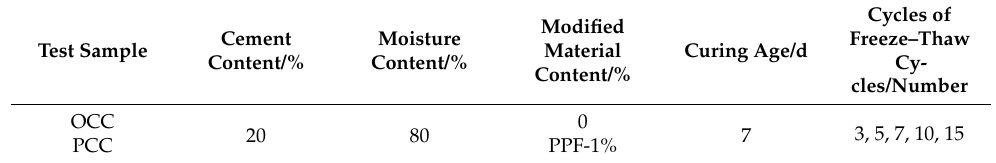
Table 4. UCS test scheme for OCC and PCC under freeze–thaw